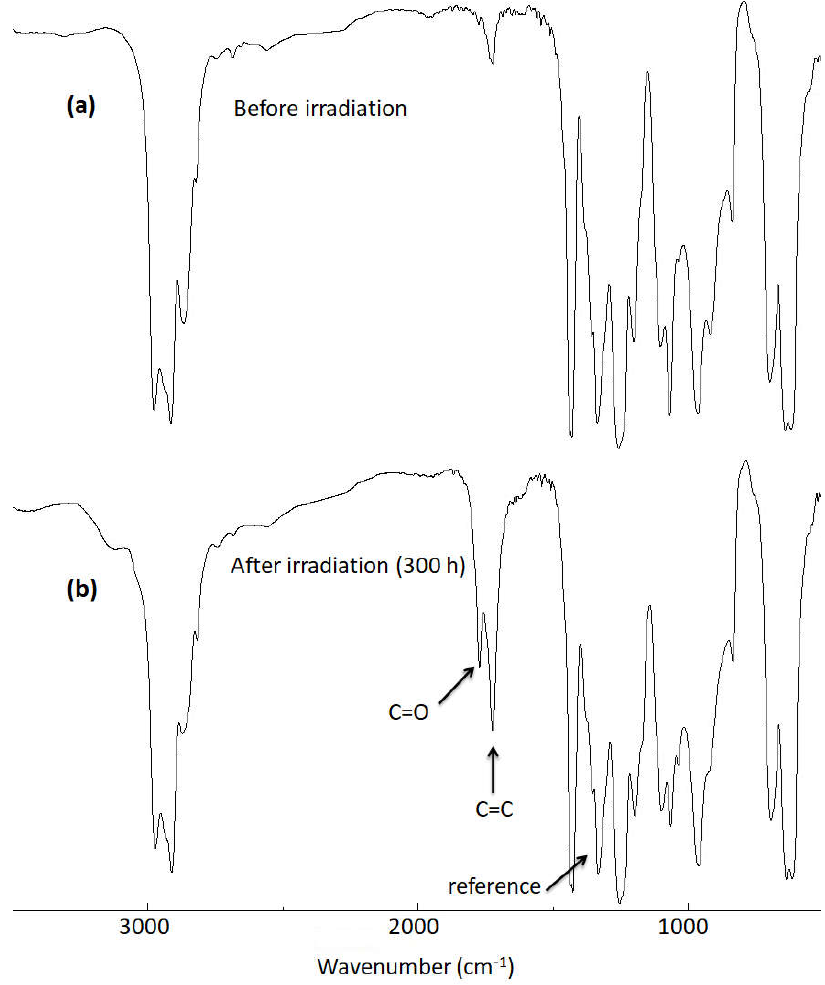
Figure 2. FTIR spectra of ( a ): blank PVC film before irradiation and ( b ): the PVC film after irradiation (300 h).